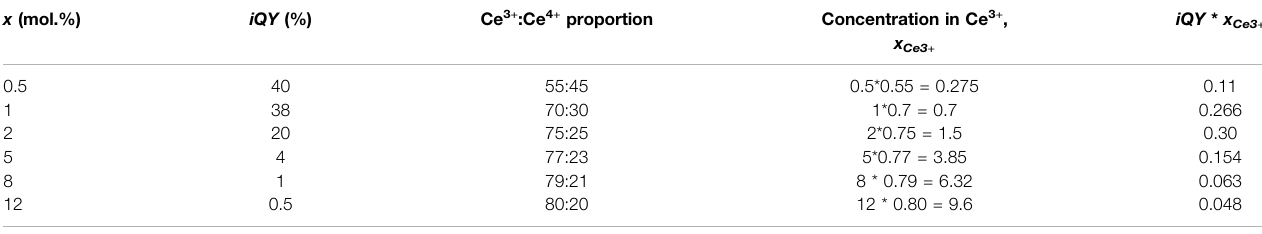
TABLE1| SummaryofthePL iQY andCe 3+ :Ce 4+ proportion,allowingthecalculationofeffectiveCe 3+ concentrationandsubsequentbrightnessobtainedbymultiplyingthe iQY by the effective Ce 3+ concentration, x Ce3+ . x (mol.%)